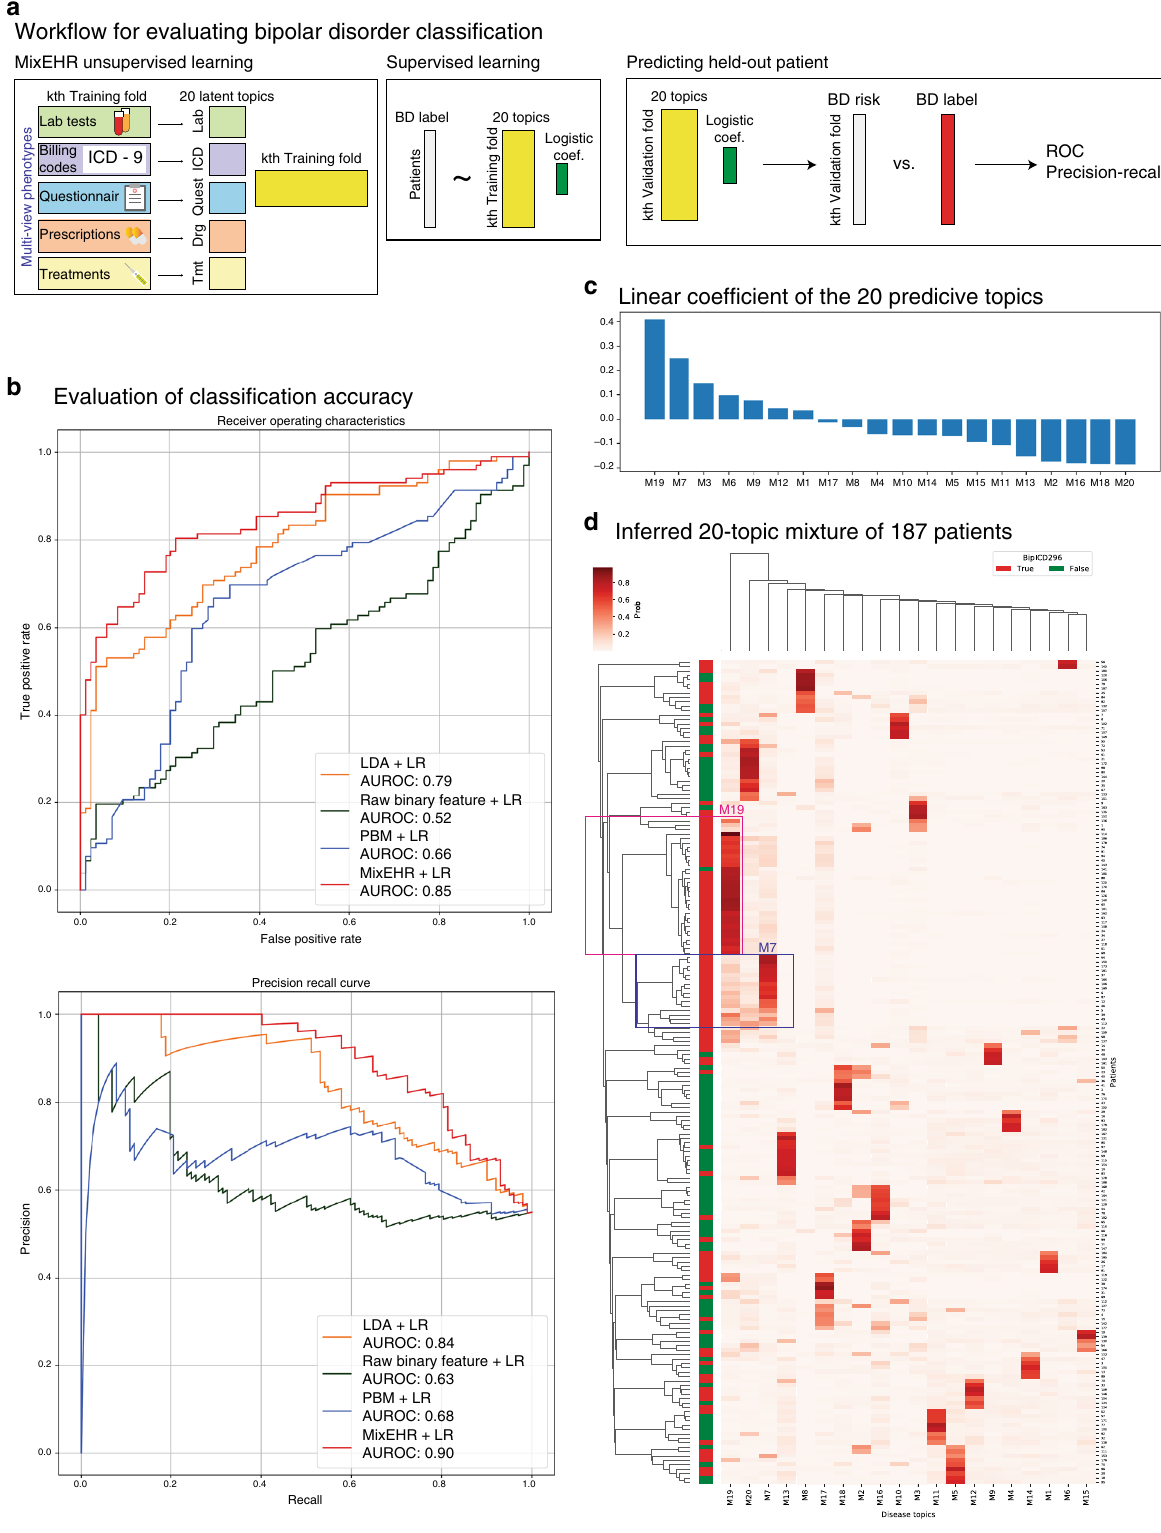
Fig. 4 Classi fi cation of bipolar disorder patients using the Mayo Clinic dataset. a Work fl ow to evaluate the classi fi cation accuracy of bipolar disorder in a fi vefold cross-validation (CV). b Classi fi cation accuracy of fi vefold CV in ROC and precision – recall curves. c Linear coef fi cients of the 20 topics ranked by decreasing order. d Inferred 20-topic mixture of 187 patients. The patients with and without bipolar disorder diagnosed were colored in red and green, respectively, on the left side of the